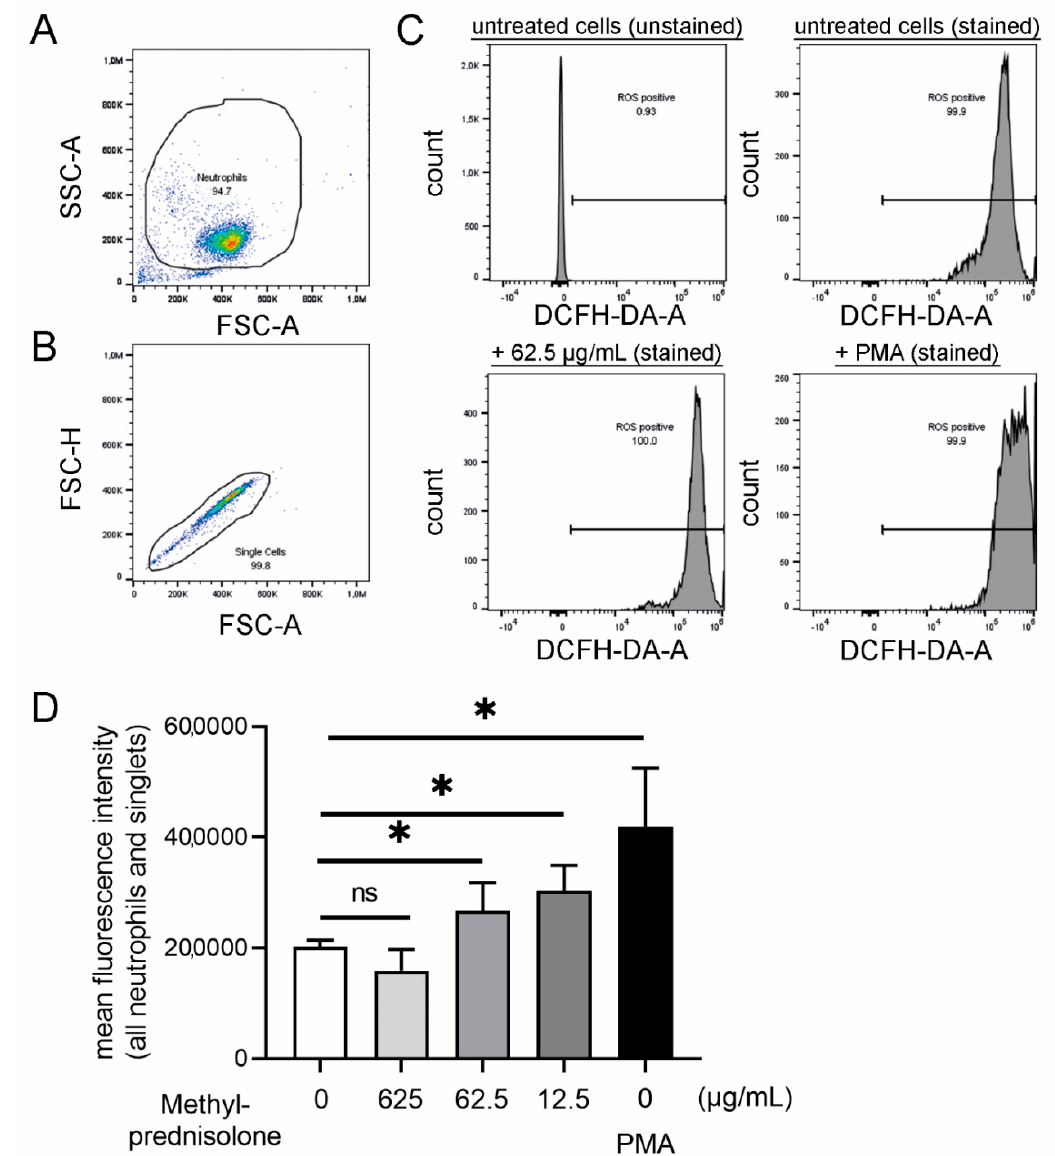
Figure 5. Isolated neutrophils produced concentration dependent higher amounts of intracellular reactive oxygen species (ROS). Phorbol 12-myristate 13-acetate (PMA) stimulation was used as the positive control in the absence of methylprednisolone. ( A – C ) The intracellular ROS production was determined by adding 2 (cid:48) 7 (cid:48) dichlorofluorescein diacetate (DCFH-DA) to unstimulated, methylprednisolone stimulated and PMA-stimulated cells. The gating strategy for the DCF-positive cells (oxidation of DCFH-DA by ROS results in fluorescence 2 (cid:48) 7 (cid:48) dichlorofluorosceindiacetate (DCF)) by flow cytometry is presented. ( A ) Based on FSC-A and SSC-A, the neutrophil population were gated. ( B ) Based on FSC-A and FSC-H, all singlets were gated from the neutrophil population. ( C ) Settings were adjusted in the gated population for ROS positive cells. Example histograms of different samples are presented. ( D ) The mean fluorescence intensity is presented and a concentration dependent increase in ROS positive cells was detectable after 45 min incubation. Data were analyzed with one-tailed paired Student’s t -test (*: p < 0.05) and are presented with mean ± SD ( n = 3 experiments with the mean of duplicates are